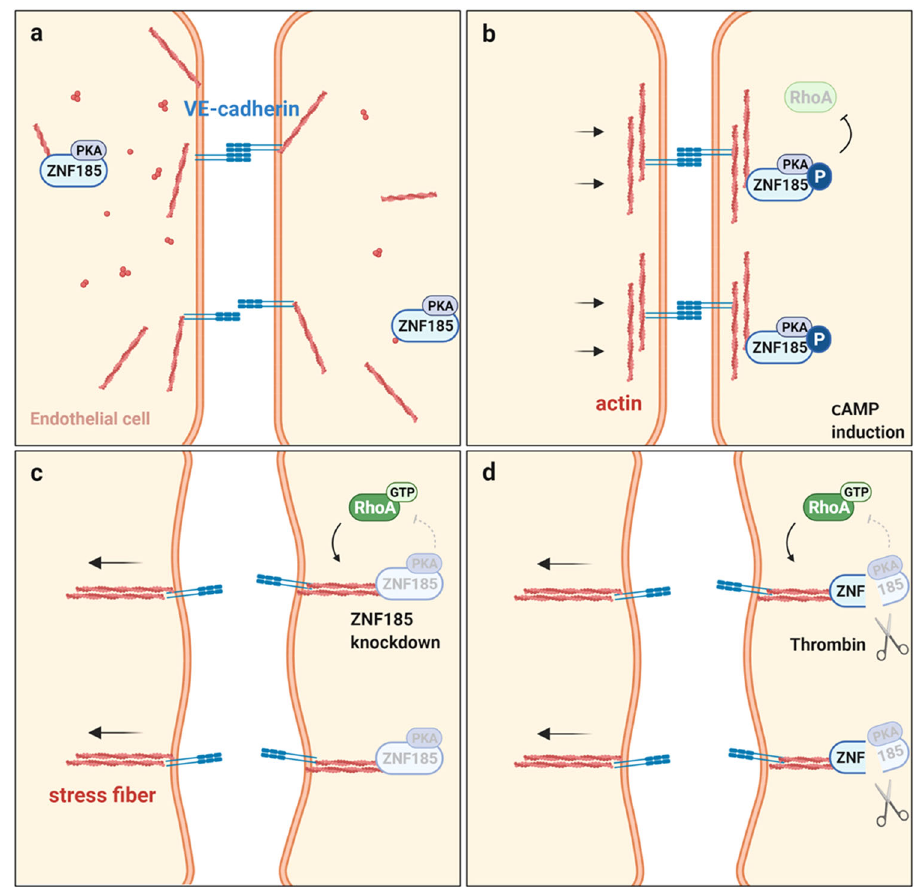
Fig. 9 Schematic summary of the role of ZNF185 in endothelial barrier function. a ZNF185 is localized to the perinuclear region under basal conditions in endothelial cells. N-terminal region of ZNF185 interacts with actin. b C-terminal region of ZNF185 interacts with PKA, which phosphorylates ZNF185. Both phospho-ZNF185 and F-actin accumulate at the membrane region in response to forskolin and stabilize cortical actin structures. c ZNF185 knockdown activates RhoA and promotes actin stress fi ber formation, causing endothelial hyperpermeability. ZNF185 is essential for cAMP/PKA-induced RhoA inhibition. d The thrombin protease divides ZNF185 into an N-terminal actin-targeting domain and a C-terminal PKA-interacting domain, which may cause RhoA activation and stress fi ber formation. Schematics were created with